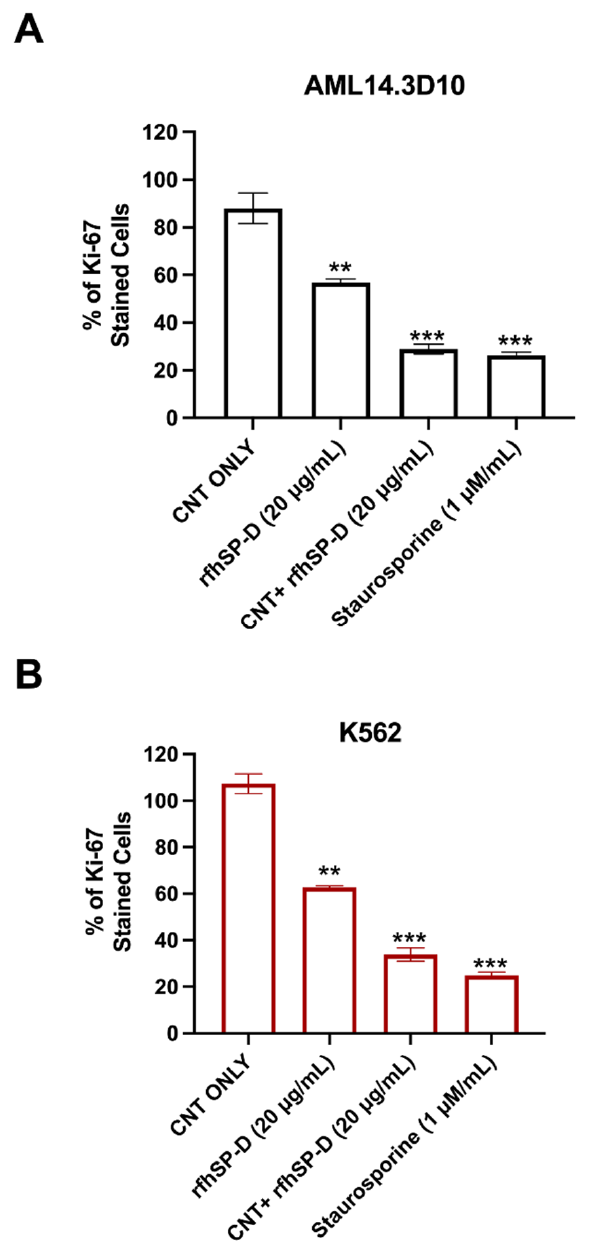
Figure 4. Anti-proliferative effects of CNT + rfhSP-D on AML14.3D10 ( A ) and K562 ( B ) cell lines. Values are means ± SD. ** p < 0.01, and *** p < 0.001 compared to CNT group only. The raw data are available as Supplementary Materials.